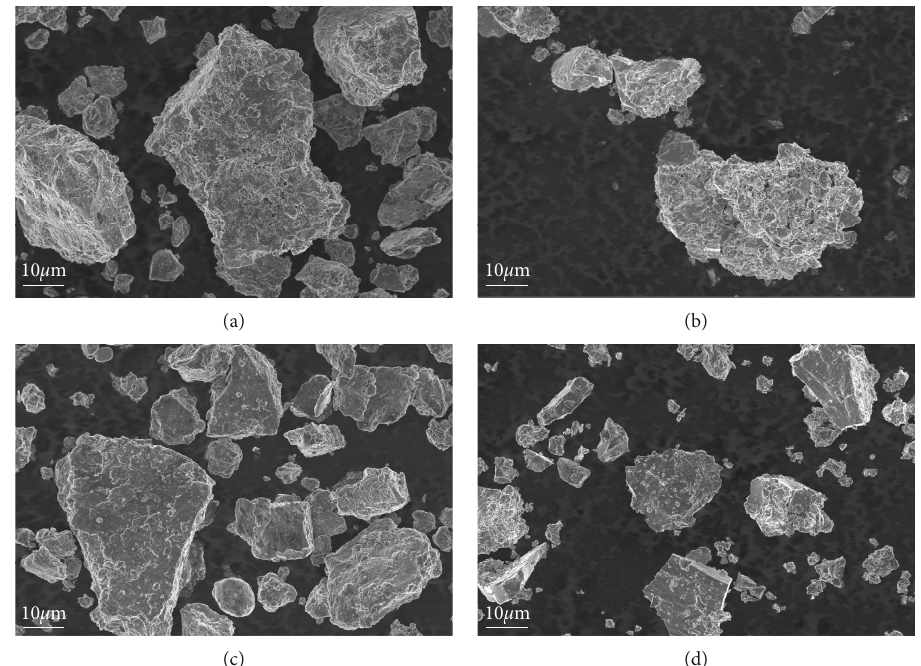
Figure 4: SEM image of HCX-1 ball milling: (a) 9h; (b) 13h; (c) 17h; (d) 21h.